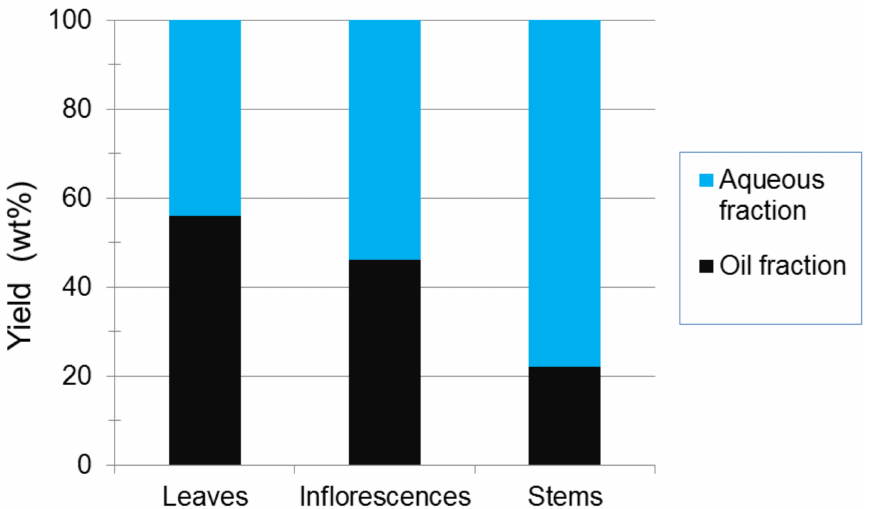
Figure 4. The content of the fractions in the pyrolysis liquid.